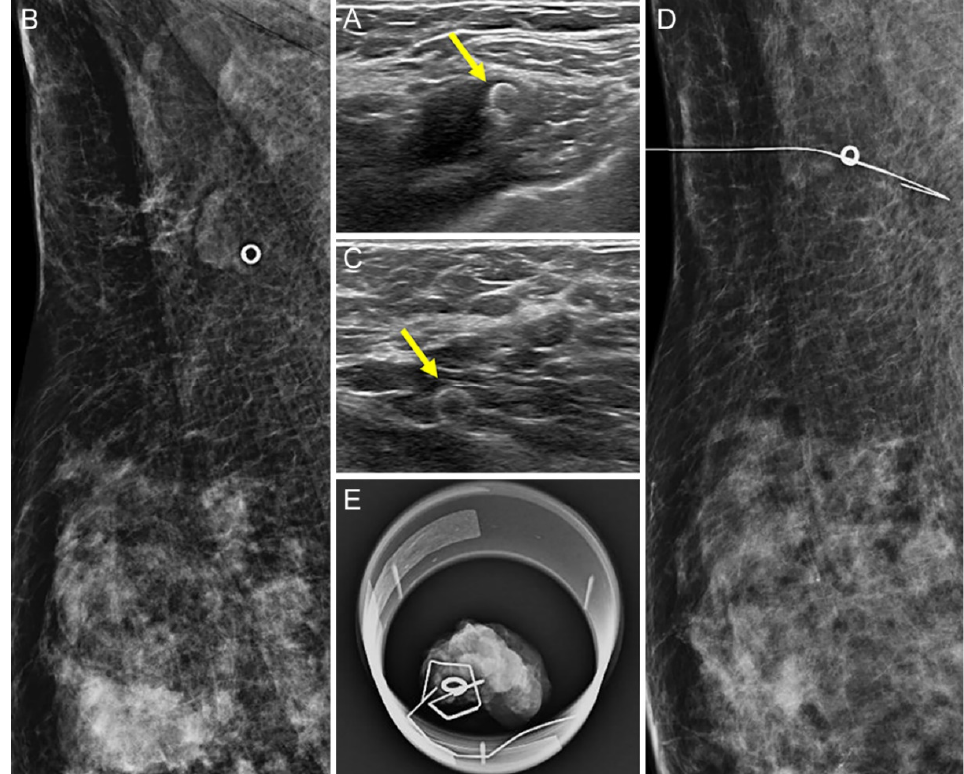
Figure 5. A 44-year-old woman with right breast cancer and ipsilateral axillary metastatic lymph node (LN) underwent UltraCor Twirl insertion prior to neoadjuvant chemotherapy (NAC). ( A , B ): The clip (arrow) was deployed at the cortex of the histologically proven metastatic LN by US ( A ) and the location was confirmed by mammography ( B ). (C– E ): After NAC, residual suspicious lymph nodes were no longer detected on US, but the previously inserted ring-shaped clip (arrow) was clearly visible ( C ). US-guided wire localization of the visible clip was performed, and the wire was successfully located at the clipped LN on mammography ( D ). Subsequent specimen mammography confirmed the successful retrieval of the clipped LN ( E ). Table 2. Comparison of US visibility between the two tissue markers.